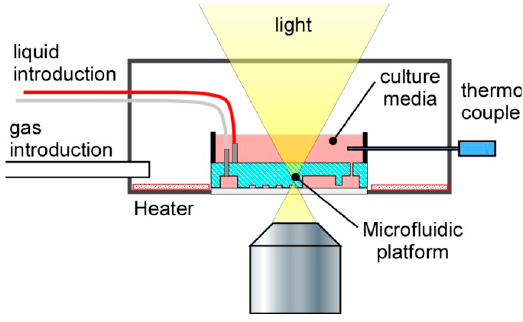
Figure 12. Experimental Setup.